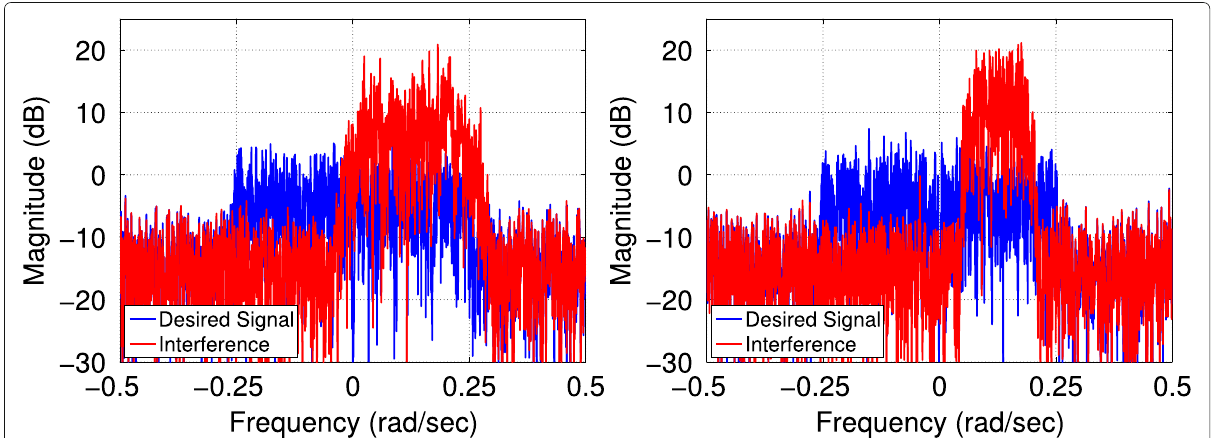
Fig. 6 Two plots showing the spectrum of the received signal when E b / N 0 = 7 dB and P i / N 0 = 20 dB. The blue line represents the desired signal, and the red line represents the interference. a An example of the spectrum when theinterference covers 1/2 of the bandwidth. b An example of the spectrum when the interference covers 1/4 of the bandwidth